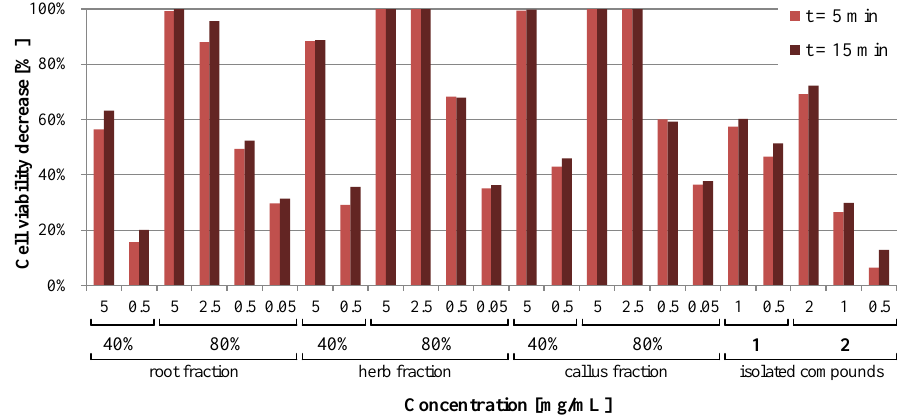
Figure 8. Comparison of the acute toxicity of 40% and 80% aqueous methanolic fractions from Lychnis flos-cuculi extracts and isolated ecdysteroids after 5 and 15 min, measured using the Microtox assay.